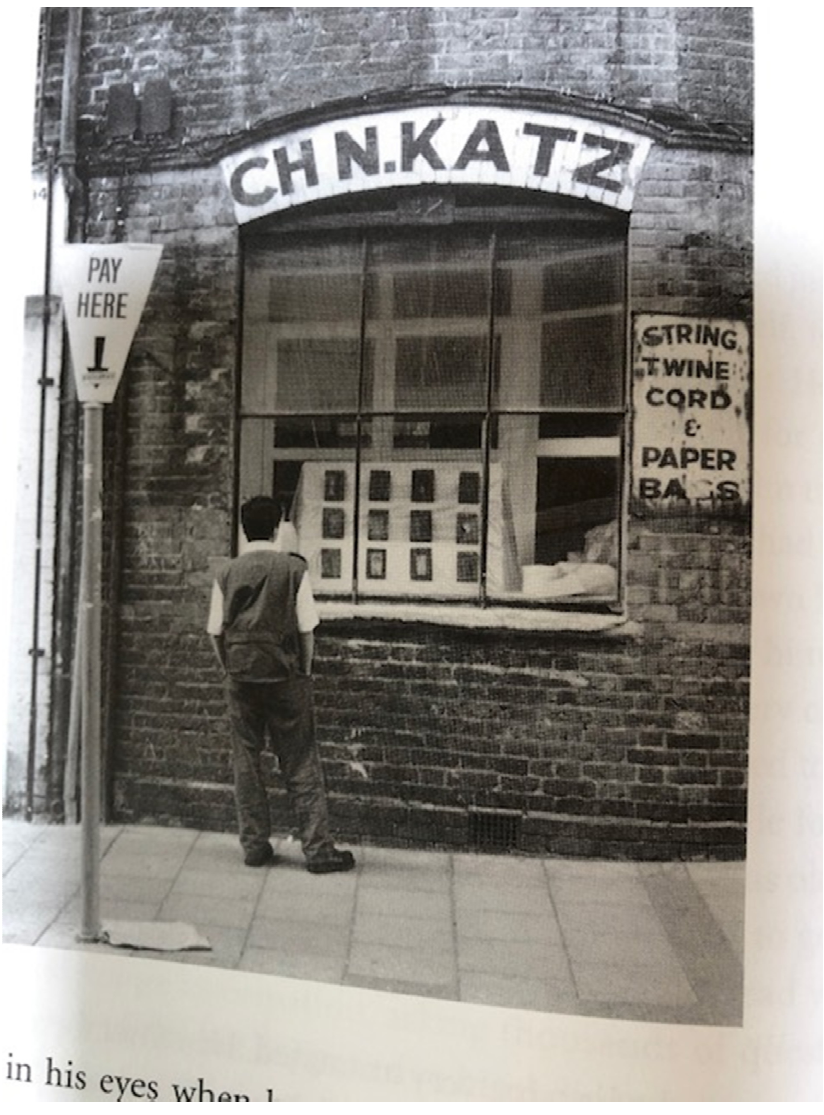
Figure 2. Ner Htamid.